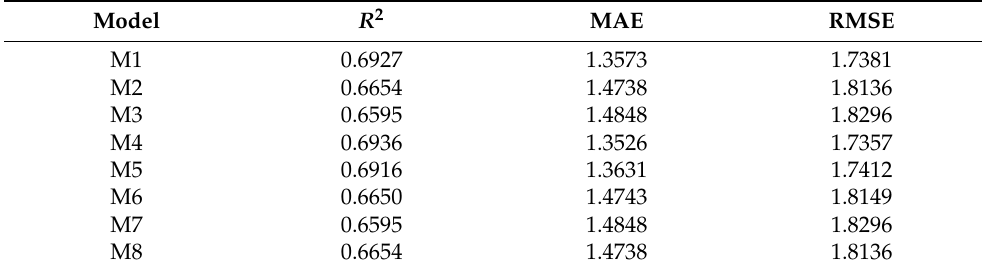
Table 3. The coefficient of determination ( R 2 ), the mean absolute error (MAE), and the root mean squared error (RMSE) for basic height-diameter